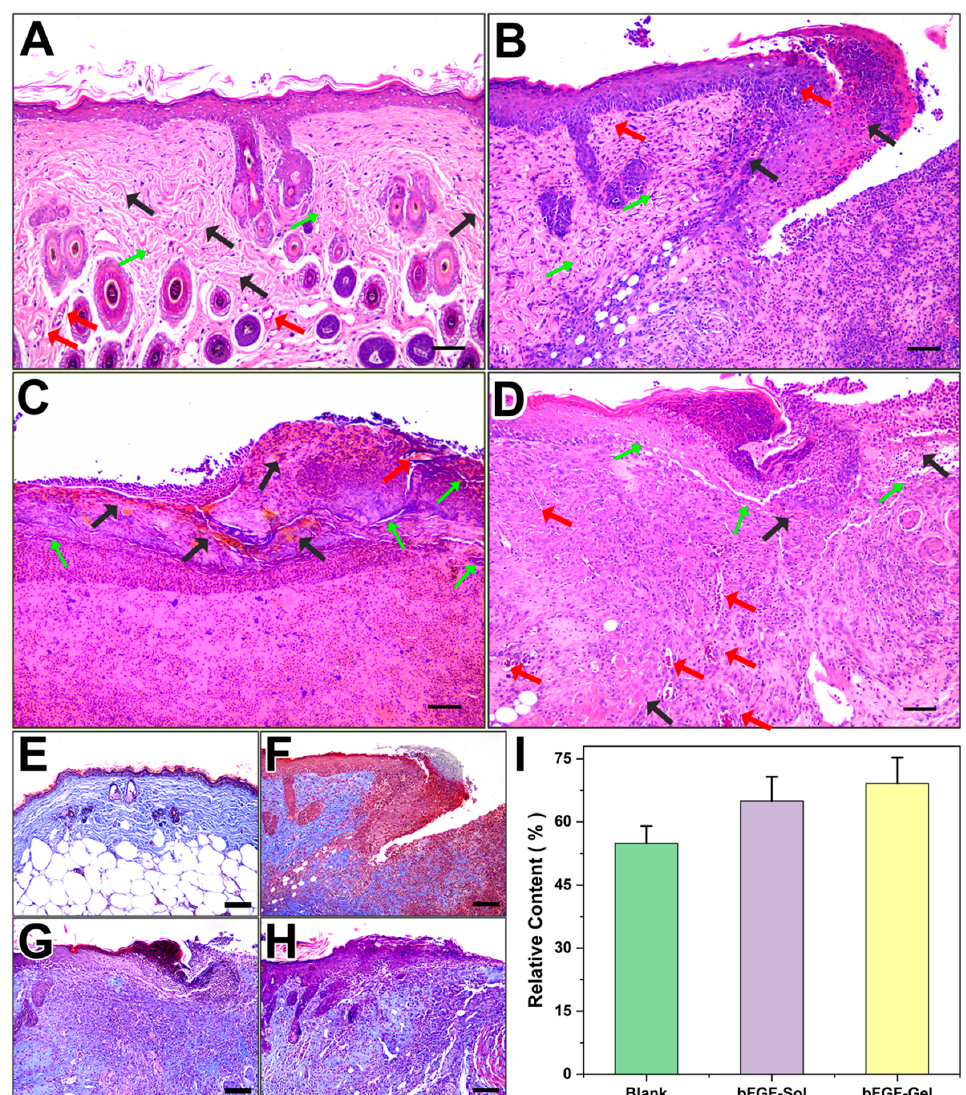
Figure 4. Histological analysis of wounds on the dorsum of mice by H&E staining after treatment with no bFGF, spraying bFGF, and hydrogel dressing containing bFGF for up to 10 days. ( A ) normal skin, ( B ) Blank, ( C ) bFGF-Sol, ( D ) bFGF-Gel. Scale bar =100 μ m. (Green arrows: fibroblasts; black arrows: collagenous fibers; Red arrows: blood capillaries.). Masson staining images from day 10 post-operation. ( E ) normal skin, ( F ) Blank, ( G ) bFGF, (H) bFGF-Gel, ( I ) relative content of collagen in different groups compared with normal skin. Scale bar =100 μ m.